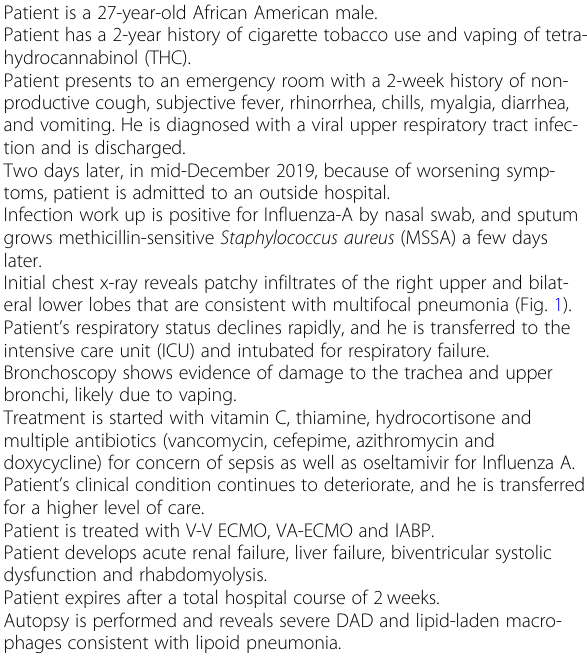
Patient is a 27-year-old African American male. Patient has a 2-year history of cigarette tobacco use and vaping of tetra- hydrocannabinol (THC). Patient presents to an emergency room with a 2-week history of non- productive cough, subjective fever, rhinorrhea, chills, myalgia, diarrhea, and vomiting. He is diagnosed with a viral upper respiratory tract